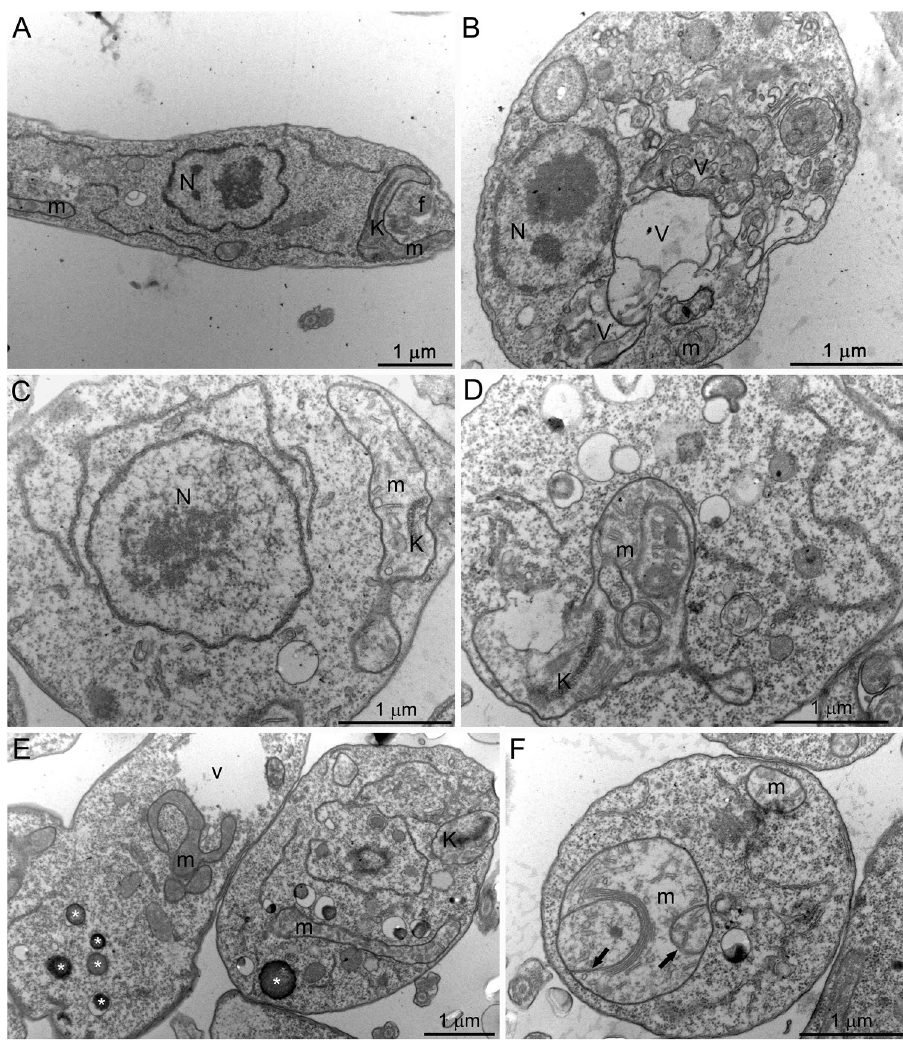
Figure 9. Ultrathin sections of Leishmania amazonensis promastigotes, control ( A ) and treated with 500 nM ( B , C ) or 1 µM SBC 39 ( D – F ) for 48 h. Several alterations were observed, such as: loss of the matrix content and vesiculation of the inner mitochondrial membrane ( C , D , F ); the presence of several giant vacuoles similar to autophagosomes engulfing portions of the cytoplasm ( B , E ); the presence of lipid bodies ( E ); and disorganization of the kinetoplast structure ( C – E ). N nucleus, m mitochondrion, f flagellum, k kinetoplast, asterisks lipid bodies, v autophagosome-like